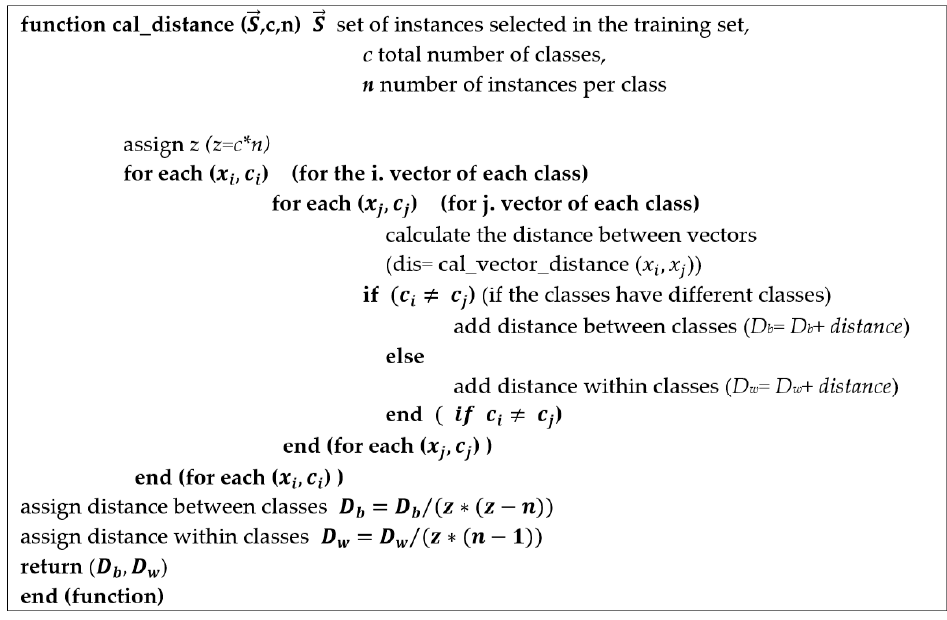
Figure 12. Calculation of between classes and within classes distance pseudo